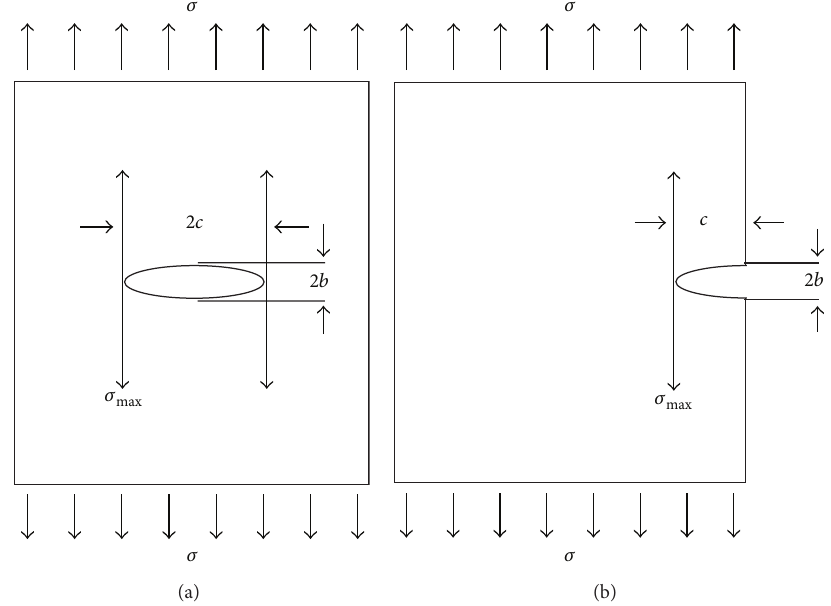
Figure 4: Maximum stress distribution 𝜎 max in a steel plate with an internal crack (a) and an external crack (b) caused by stresses 𝜎